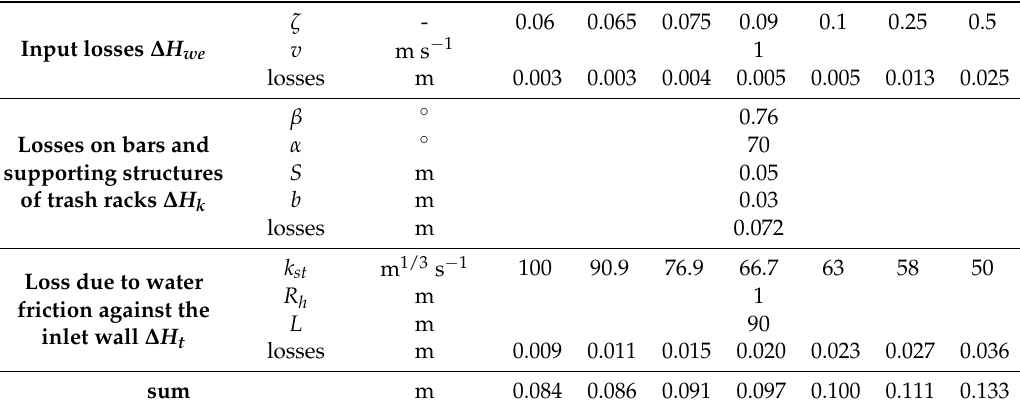
Table 7. Hydraulic losses for shape coefficient β =